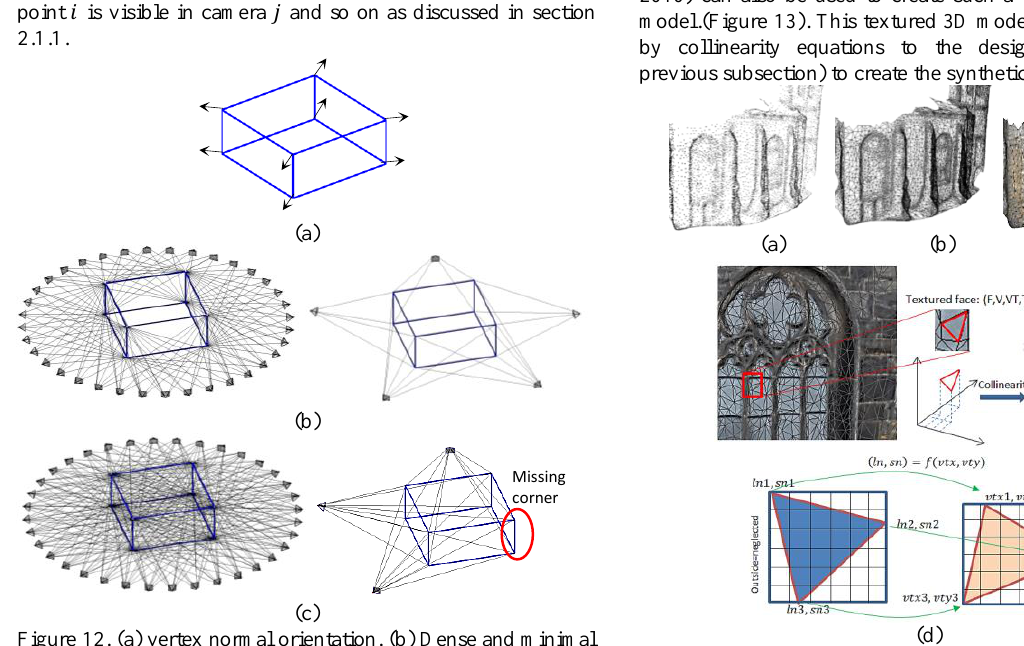
Figure 13. (a) Rough point cloud. (b) Surface mesh. (c) Textured mesh. (d) Synthesizing